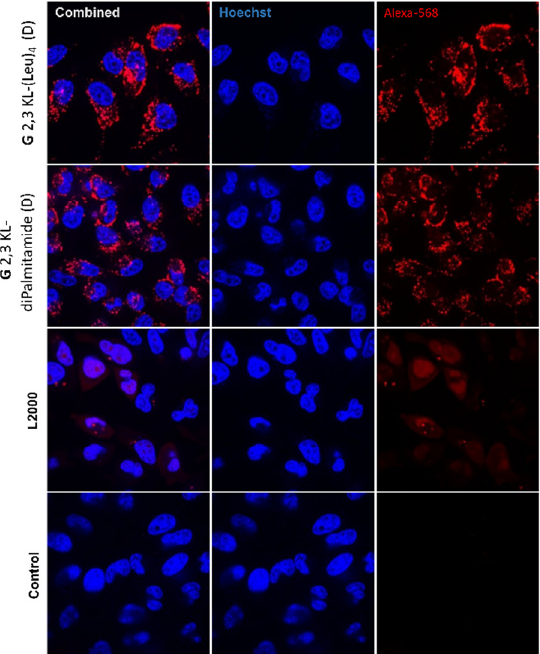
Figure 9. Live confocal microscopy imaging. Cellular uptake and distribution of ONs after HeLa Luc/705 reporter cell transfection in serum-containing media using the best performing 3rd gener- ation peptide dendrimer/Alexa-568-labelled ON/complexes formulated in different media (G 2,3 KL-(Leu) 4 (D) in OptiMEM ® and G 2,3 KL-diPalmitamide (D) in HBG). Cells were incubated for 24 h, at 37 ◦ C in a humidified incubator with 5% CO 2 before adding Hoechst dye (Thermofisher), following the manufacturer protocol. Live cell imaging was performed using a confocal microscope (A1R confocal, Nikon, Tokyo, Japan). Pictures were taken at a magnification 20 × , and analyzed with NIS-Elements software (Nikon, Tokyo, Japan).